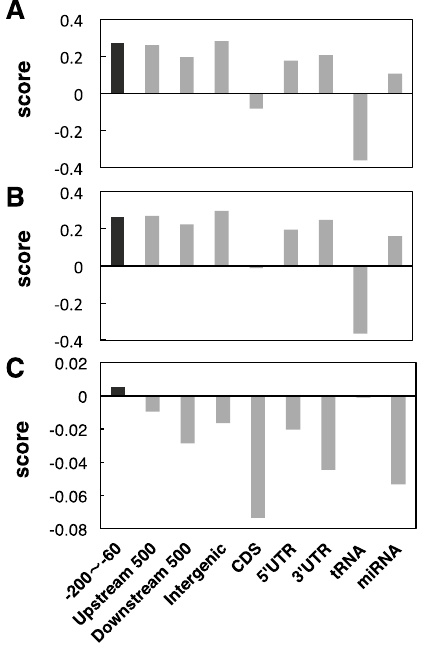
Figure 2. Score of genic domains and transcribed region of a few gene categories. Evaluated sequences of the categories were obtained from TAIR10. ( A ) Intergenic Index (IGI) prepared with the region from − 200 to − 60 bp. ( B ) Integenic Index (IGI) prepared with the region from − 750 to − 450 bp. ( C ) Promoter Index (PRI) prepared by the subtraction of IGI750_450 from IGI200_60. Categories giving positive scores in the three indices are highlighted in